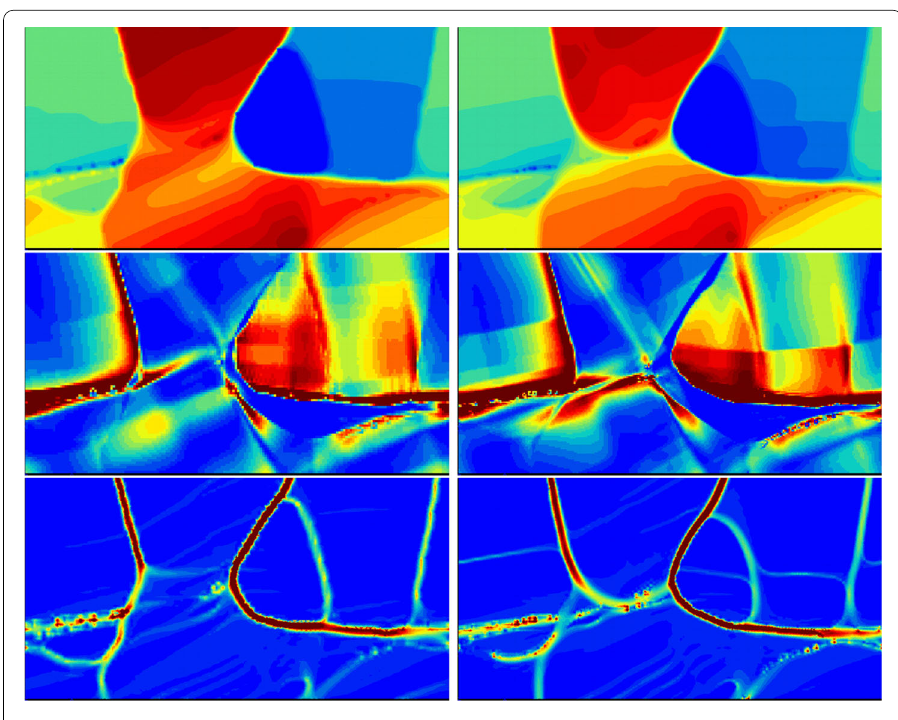
Fig. 13 A zoom on a subgrain boundary generated in the six grain microstructure due to kink band formation, c.f. Figs. 3 and 6 (the subgrain boundary appears in the lower left corner of the microstructure in those figures). Two solutions are compared after 6min of constant deformation, which is when the very localized recovery of the dislocation density starts to appear. To the left, the same mesh was used as in the previous figure whereas in the images to the right, a finer mesh was used. From top to bottom, the images show the orientation, the dislocation density ρ and the norm of the curvature |∇ θ | . The two solutions are not identical, but the same phenomena can be observed with localization near or inside regions with high local curvature and dislocation